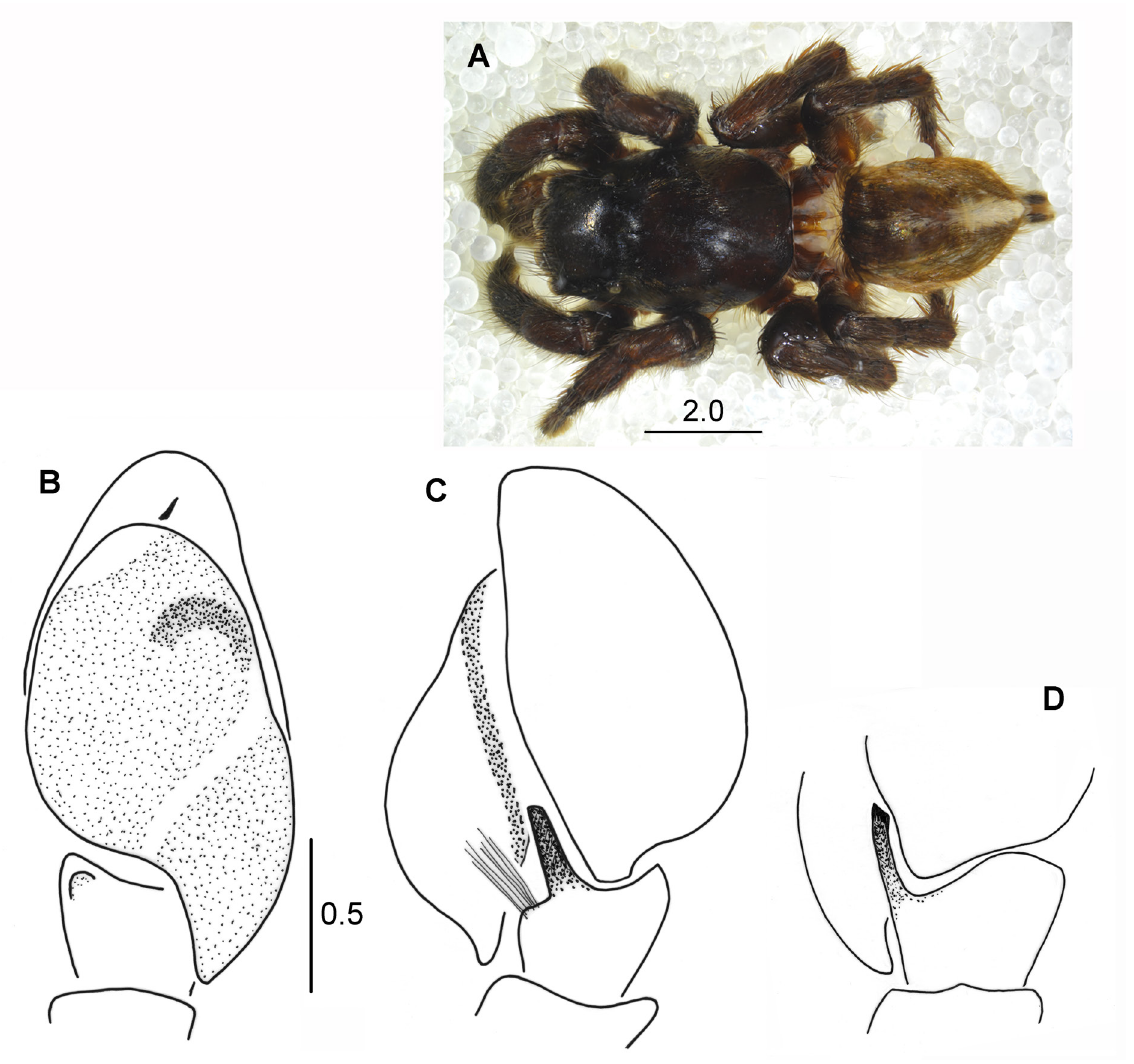
Fig. 32. Langona recta sp. nov., paratype, ♂ (MNHN). A . Habitus, dorsal view. B . Palpal organ, ventral view. C . Palpal organ, lateral view. D . Tibial apophysis, dorsal